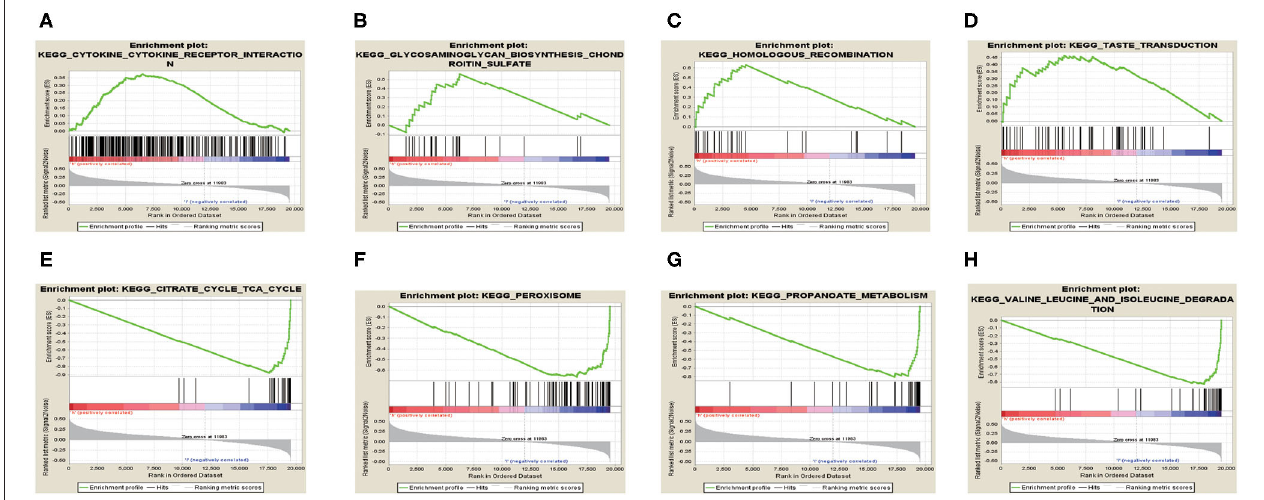
FIGURE 8 | Gene set enrichment analysis. (A–D) The four most significantly enriched signaling pathways enriched in the high TRIM46 expression phenotype, respectively. (E–H) The four most significantly enriched signaling pathways enriched in the low TRIM46 expression phenotype,